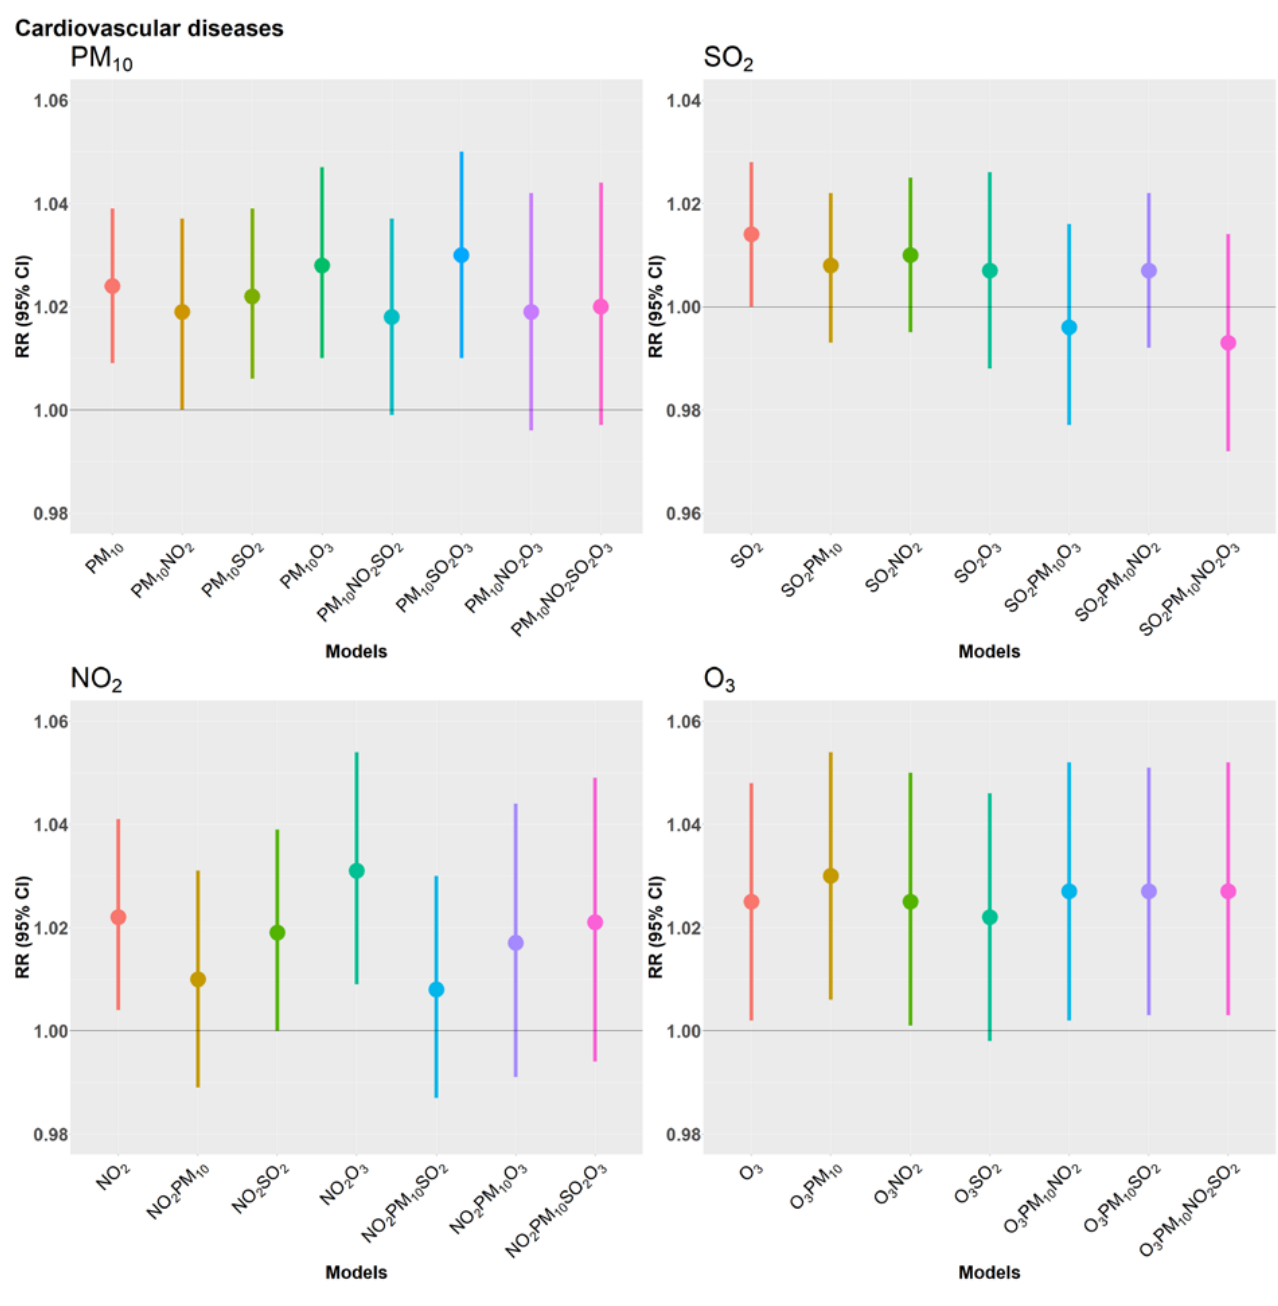
Figure 1. Overall relative risks estimated from Quasi-Poisson regression models of daily counts of cardiovascular disease deaths, adjusting for time trends and seasonal variation, day of the week, public holiday, temperature and relative humidity. Estimates are presented per IQR µ g/m 3 increase in the two-day moving average (lag 0–1) of PM 10 , NO 2 , SO 2 and O 3 for the respective two-, three- and four-pollutant